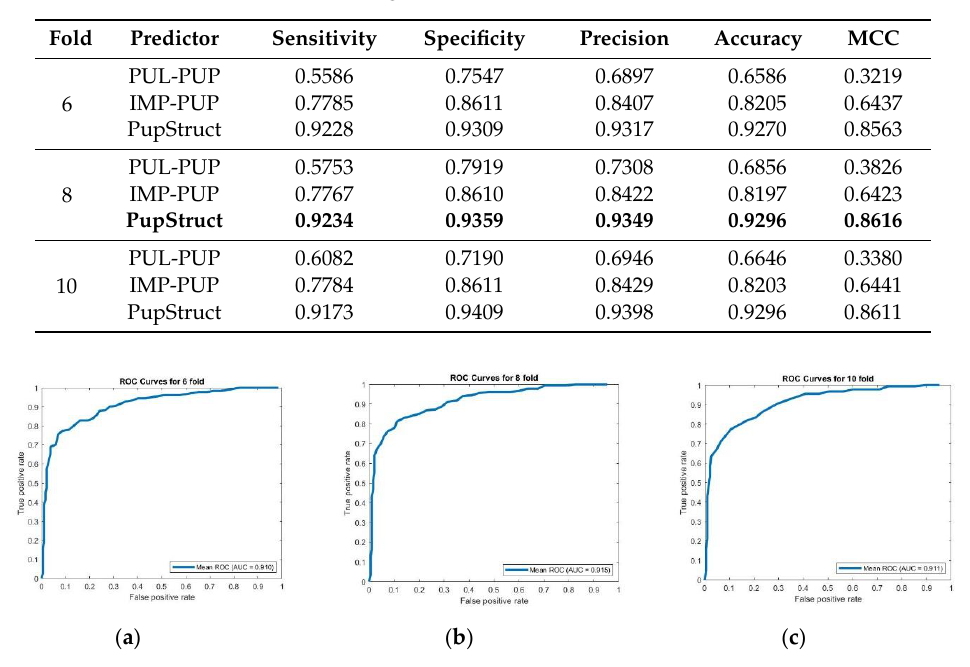
Figure 4. Shows mean Receiver operating characteristic (ROC) curves of PupStruct predictions on 6-, 8- and 10-folds ( a ) ROC curves for 6 folds, ( b ) ROC curves for 8 folds, ( c ) ROC curves for 10 folds.This